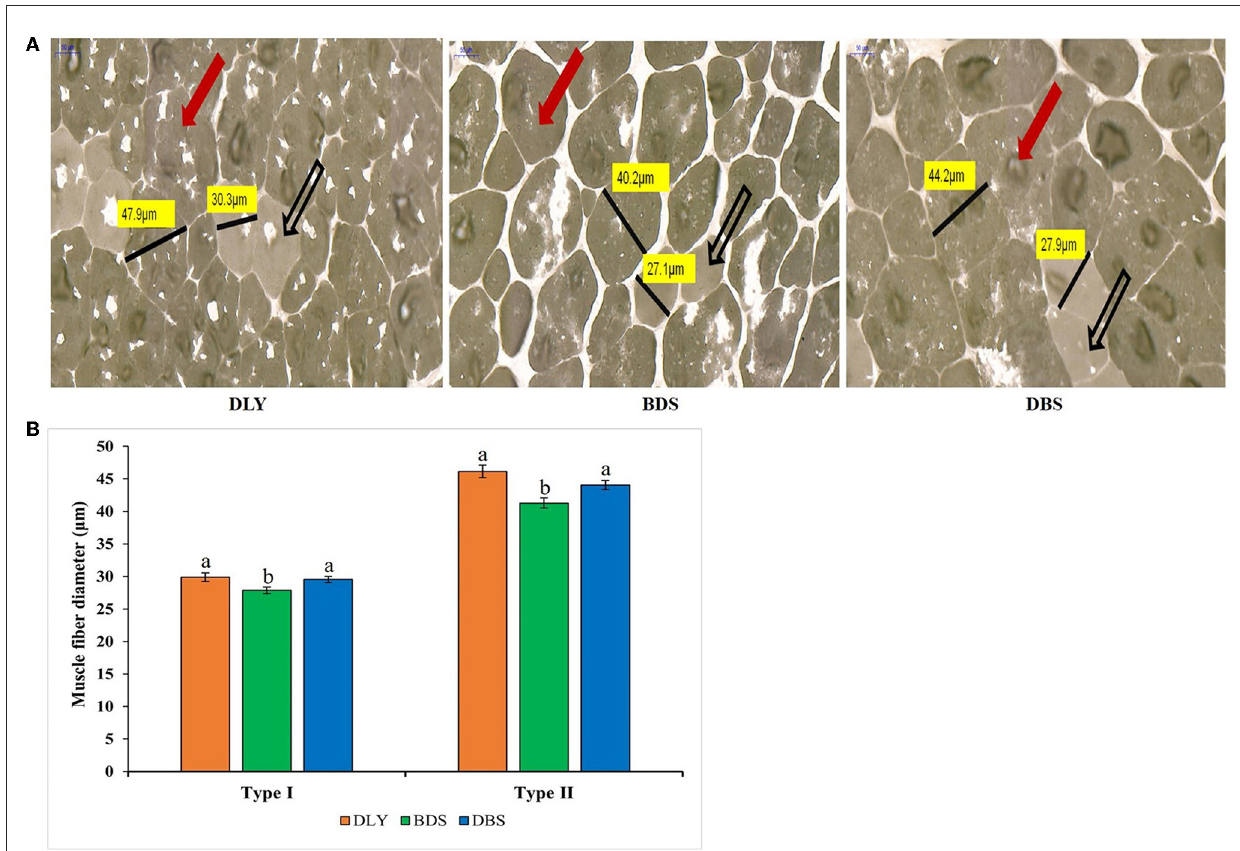
FIGURE1 Muscle fiber typing and diameter measurement. (A) Frozen sections of ATPase in longissimus dorsi muscle of different hybrid pigs. Black hollow arrow indicates type I muscle fiber, red solid arrow indicates type II muscle fiber, and black line segment is measured length of muscle fiber diameter. (B) Comparison of longissimus dorsi muscle fiber diameter from different hybrid pigs. Significant differences ( p < 0.05) are indicated by different letters. DLY, Duroc × (Landrace × Yorkshire); BDS, Berkshire × (Duroc × Saba); DBS, Duroc × (Berkshire ×